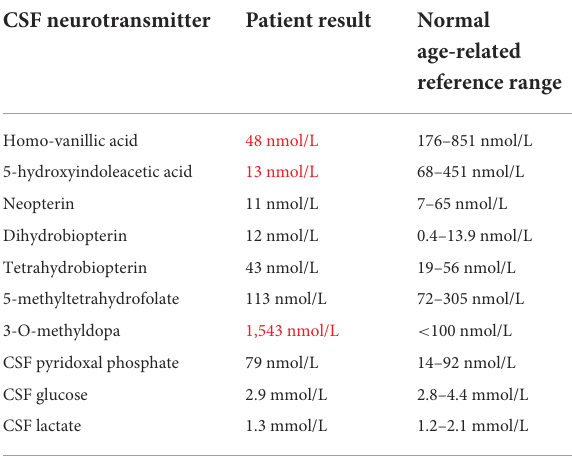
TABLE 1 CSF fluid neurotransmitter analysis